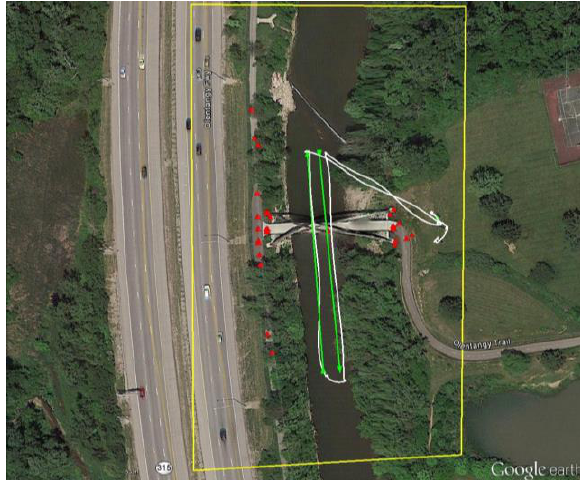
Figure 3. Test site location including: flight lines (green), actual flight trajectory (white), GCPs position (red), and approximated image block range